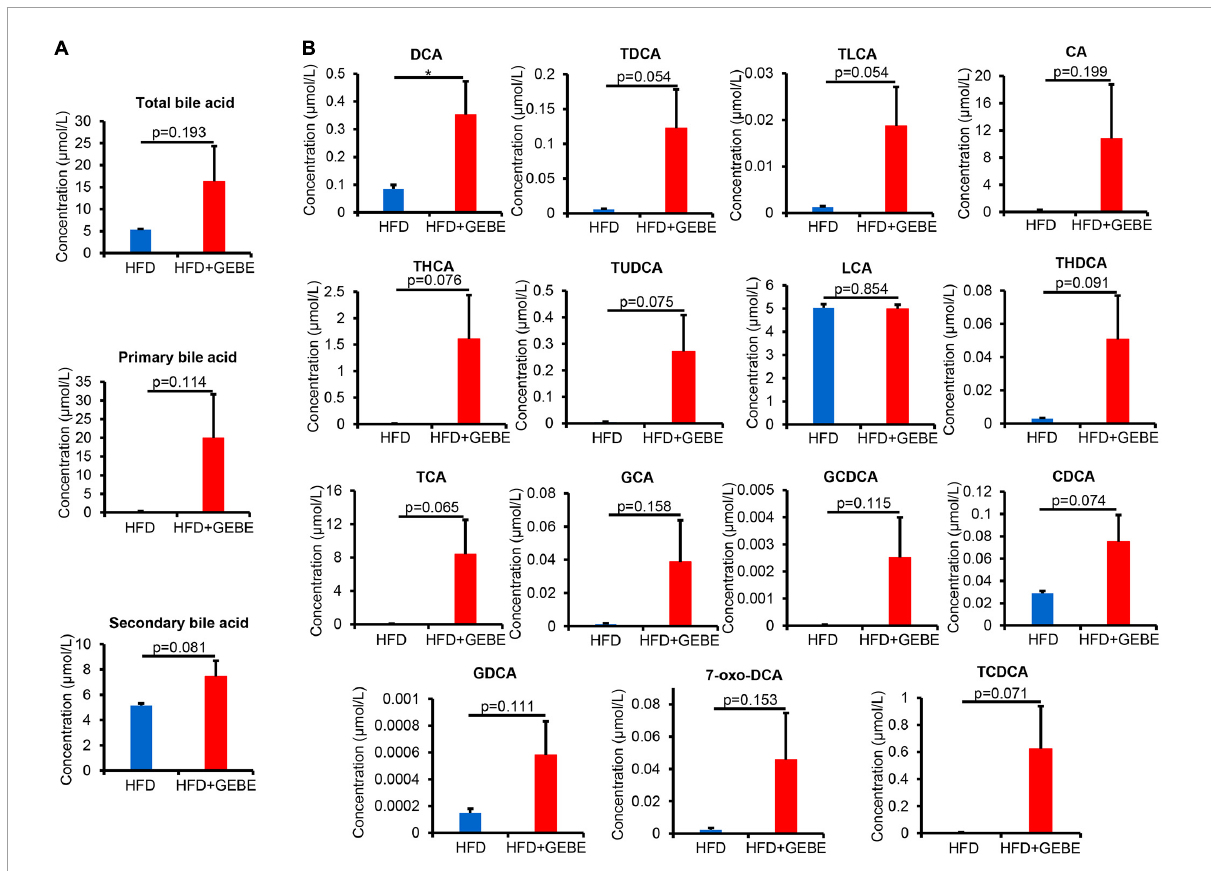
FIGURE5 GEBE supplementation alters the serum bile acid profile in HFD-induced C57BL/6 mice ( n = 8). (A) Serum levels of total bile acids, primary bile acids, and secondary bile acids in HFD-induced mice with GEBE treatment. (B) Bile acid levels in the serum. * p < 0.05. NS, not statistically significant. The results are presented as mean ± SEM. HFD, High-fat diet; HFD + GEBE, High-fat diet with